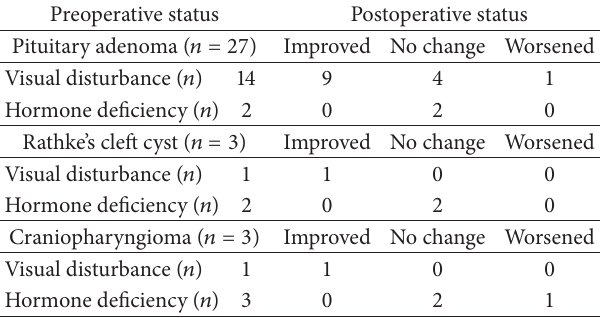
Table 2: Outcome of endoscopic transsphenoidal surgery with multimodal assistant systems in the visual and endocrinological functions. When deterioration of either visual acuity or visual field was recognized, the patient was defined to have worsened visual disturbance. When replacement of more than one pituitary hormone was required compared to preoperative hormonal status, the patient was defined as being a worsened status in the pituitary